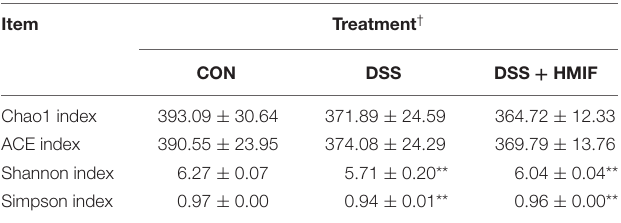
TABLE 5 | Effects of ethanol extracts from Morchella importuna on the α -diversity indexes in the colon of DSS-challenged